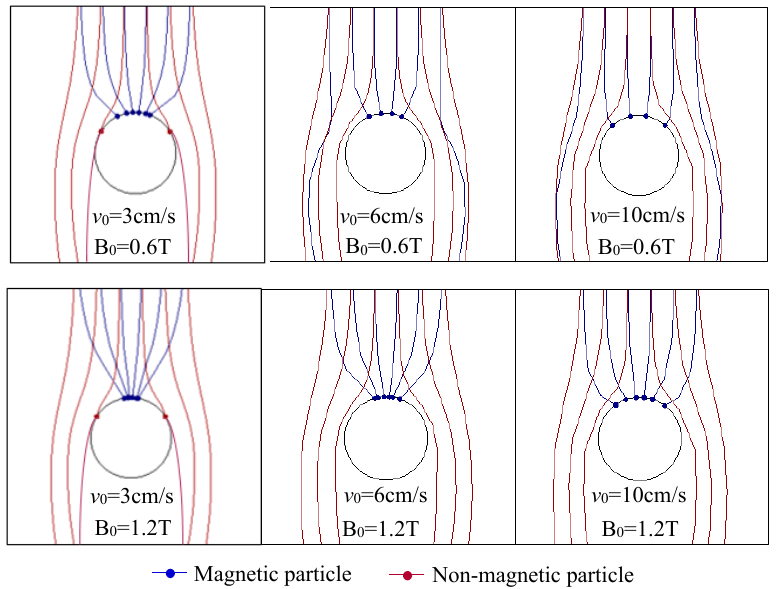
Figure 2. Simulated trajectories of independent particles in capture of single-wire.